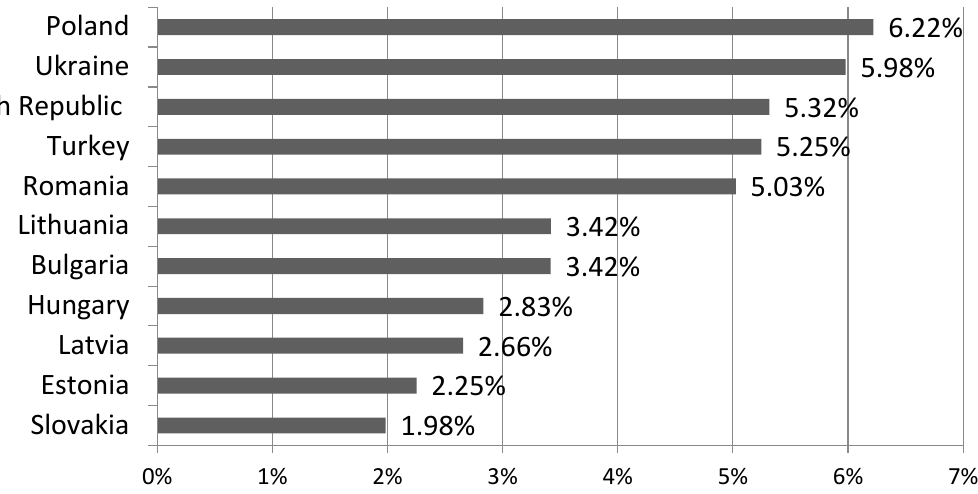
1.98% Figure 5. Stability of the level of business environment security, %